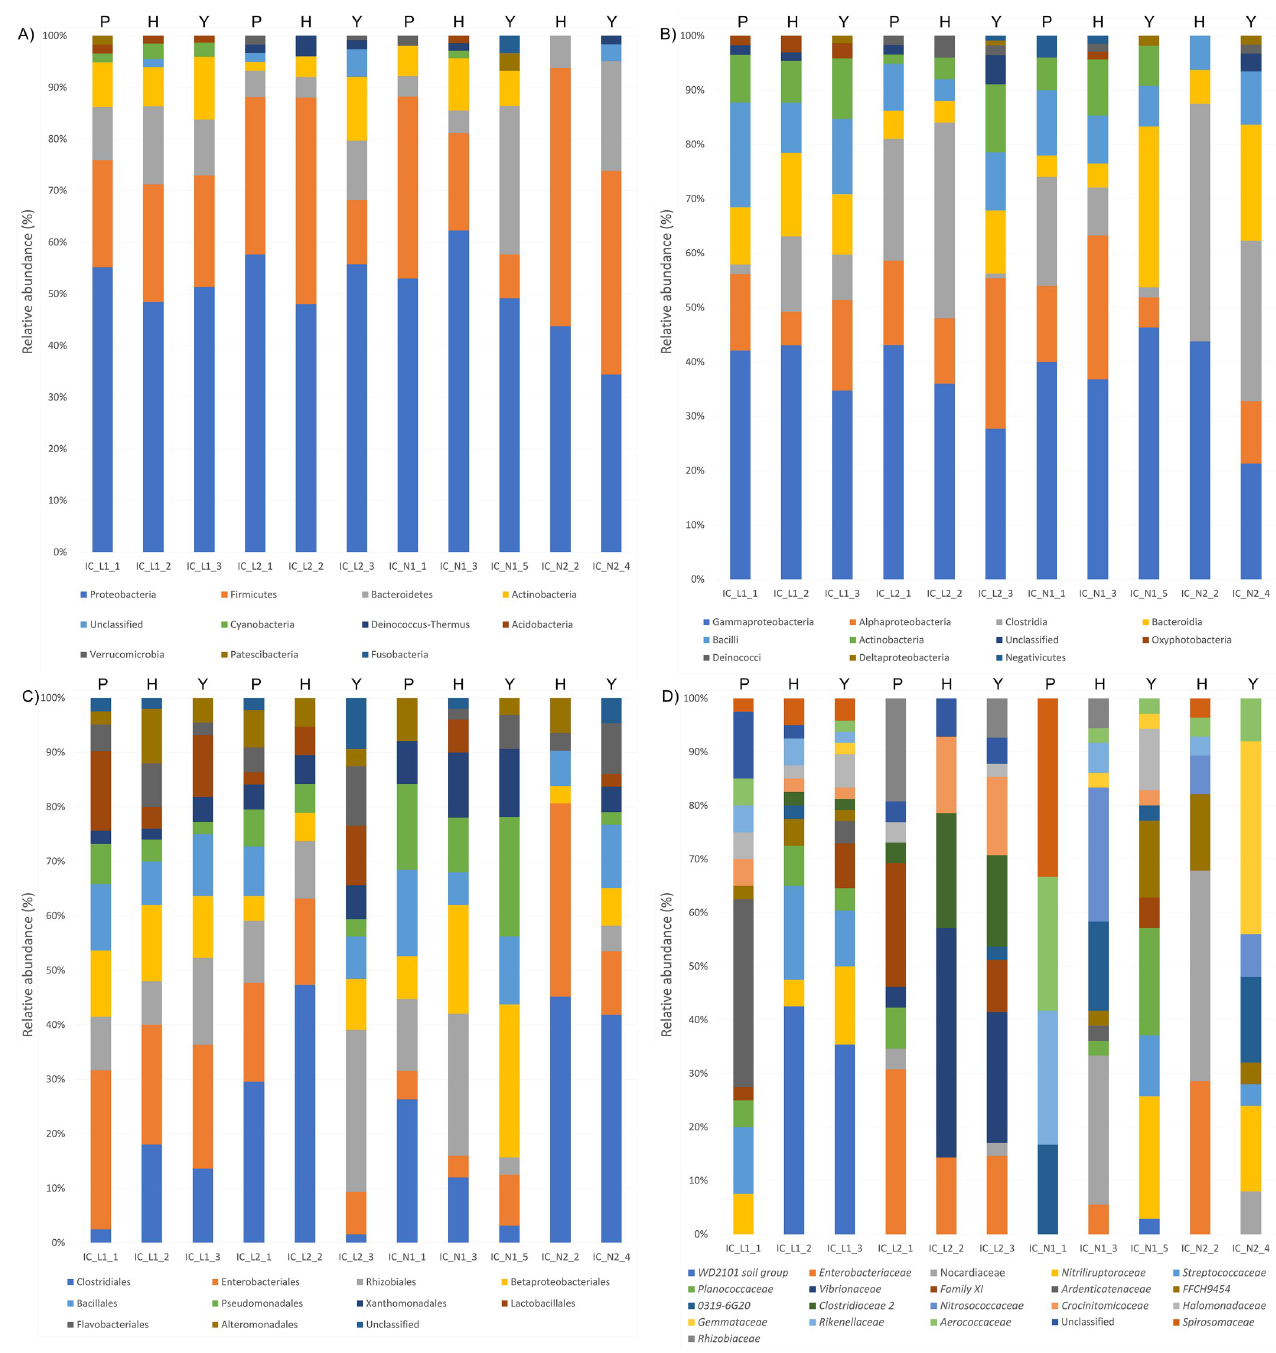
Fig 6. Percentage of the main 10 phyla (A), 10 classes (B), 10 orders (C) and 20 families (D) found in samples of internal content, collected from Linosa 2018 (indicated as IC_L1), Linosa 2019 (indicated as IC_L2), Ascea Marina (indicated as IC_N1) and Eboli (indicated as IC_N2). IC_L1_1, IC_L2_1 and IC_N1_1 were from pipping sea turtles (indicated with a P), IC_L1_2, IC_L2_2, IC_N1_3 and IC_N2_2 were from hatchlings (indicated with an H), the other samples derived from the yolk collected from the unhatched eggs (indicated with a Y).